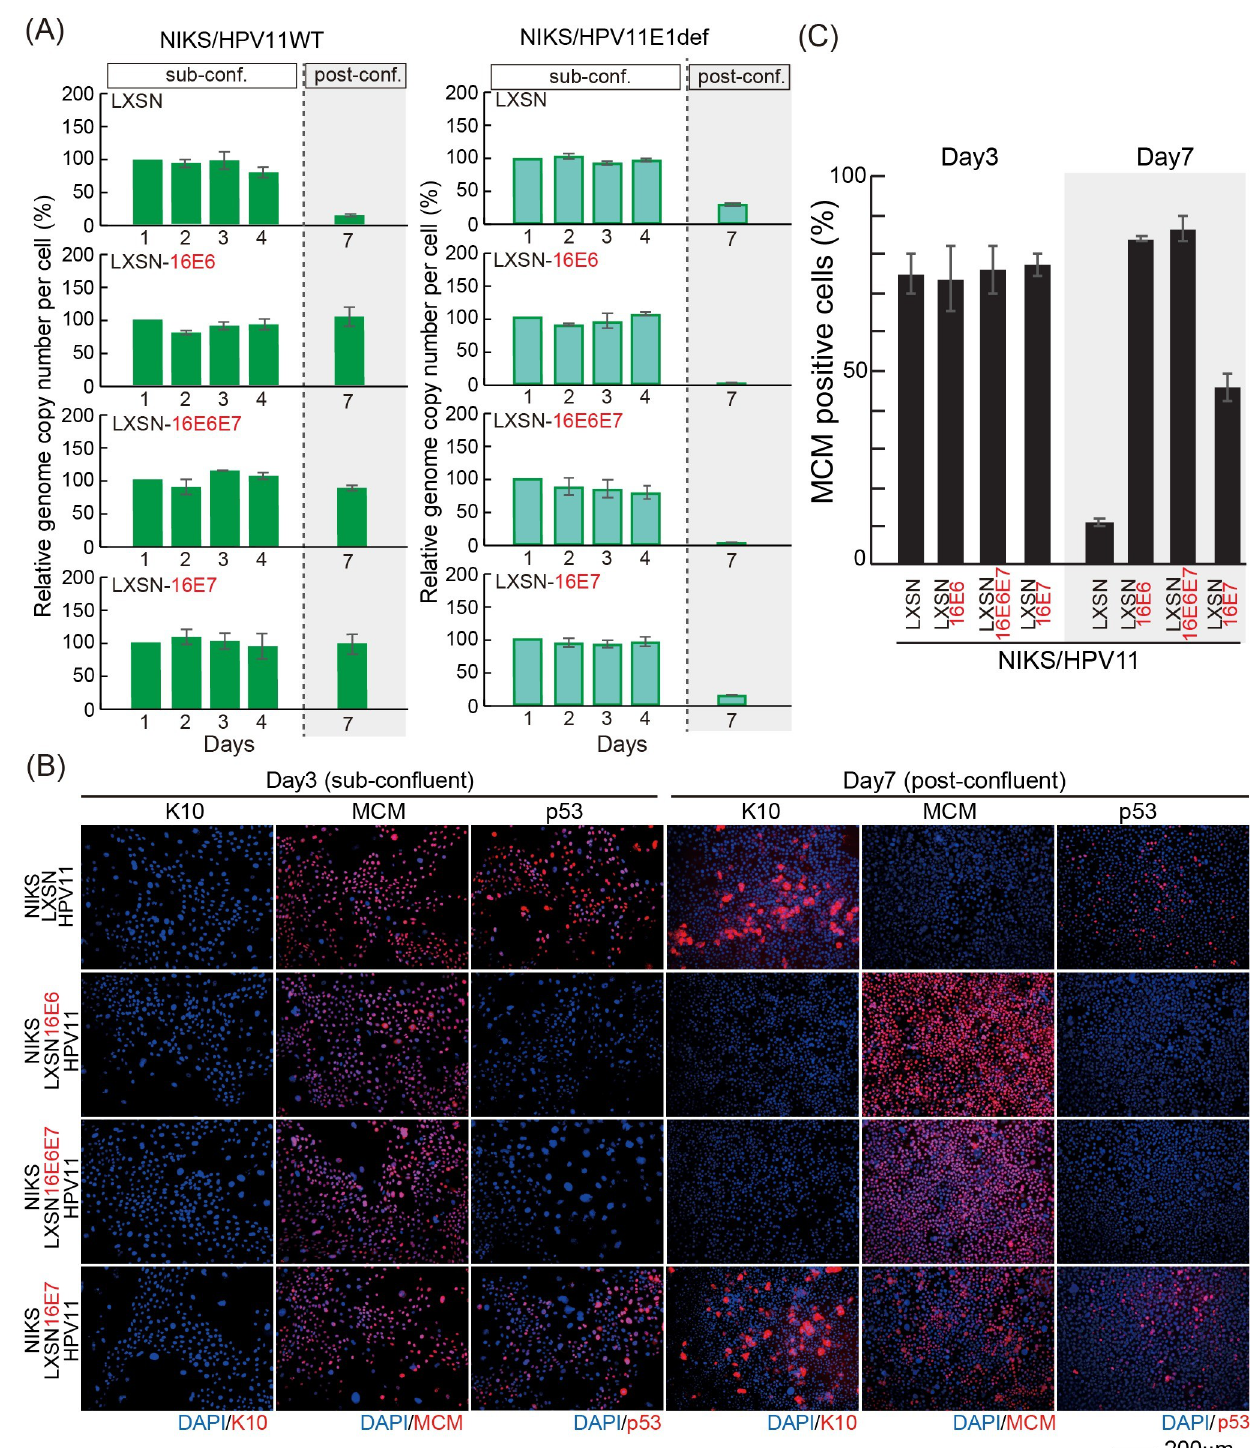
Fig 5. Low-risk HPV is maintained in NIKS expressing high-risk HPV E6 and E7 post-confluence. (A) The virus genome copy number per cell of HPV11 (left) and HPV11 E1def (right) transfected into NIKS or NIKS expressing HPV16 E6 and/or E7, was measured and prepared for presentation as outlined in Fig 1E. (B) NIKS or NIKS expressing HPV16 E6 and/or E7 at days 3 and 7 were stained with K10 (red); MCM (red), p53 (red), and DAPI (blue). Bar = 200 μ m. (C) The proportion of MCM positive cells shown in (B) is quantified and shown.